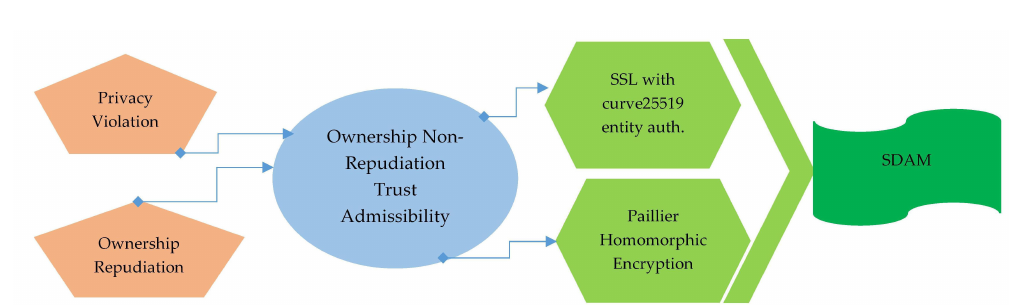
Figure 3. Secure Topos methodology.